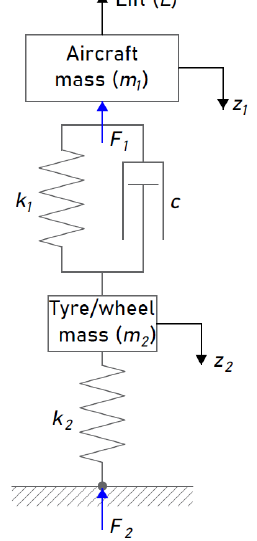
Figure 2. Typical dynamic model of the main aircraft landing